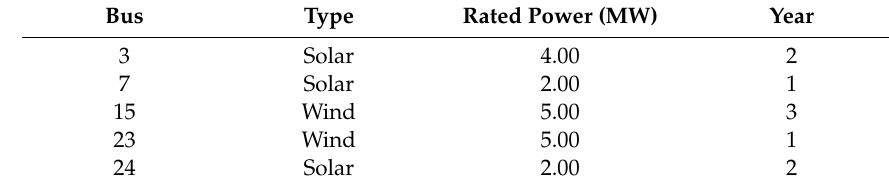
Table 2. Future DG units.